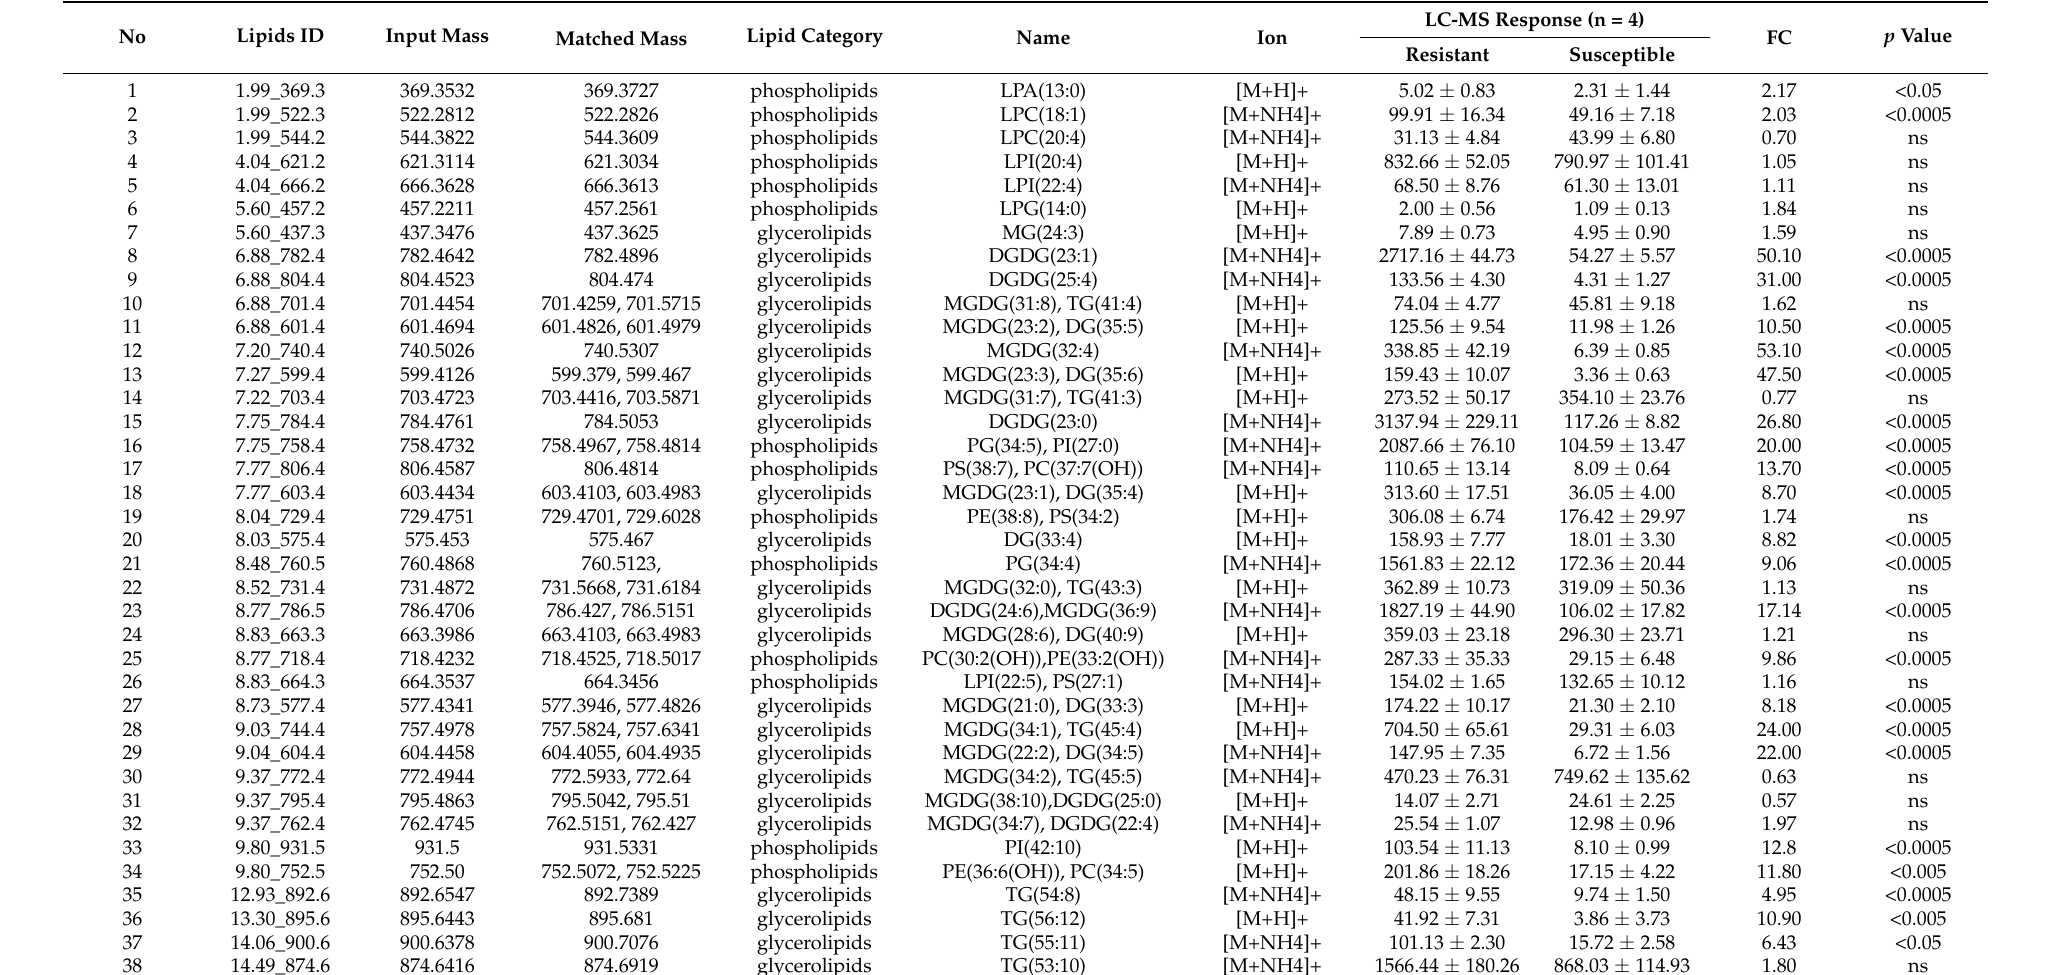
Table 1. Glycerolipids and phospholipids candidates obtained from T. castaneum